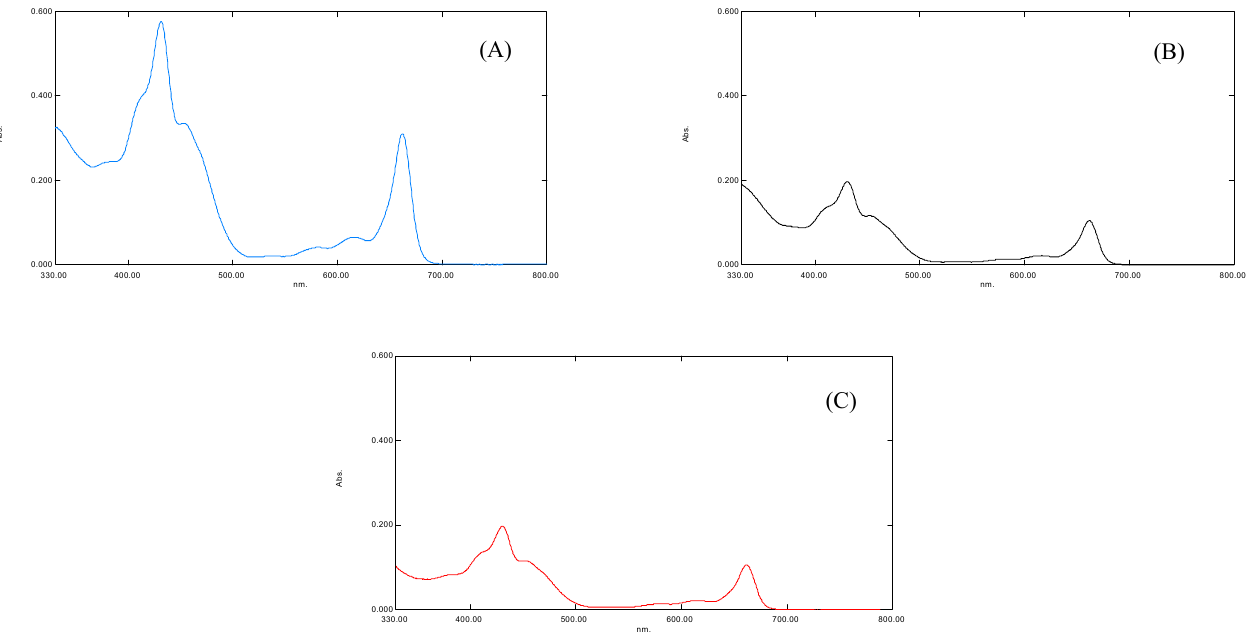
Figure 3. ( A ) showing UV-Vis spectra of S. oleracea leaves for control plant “a”, ( B ) for Copper stress plant “b”, and ( C ) for Lead stress plant “c”, respectively.